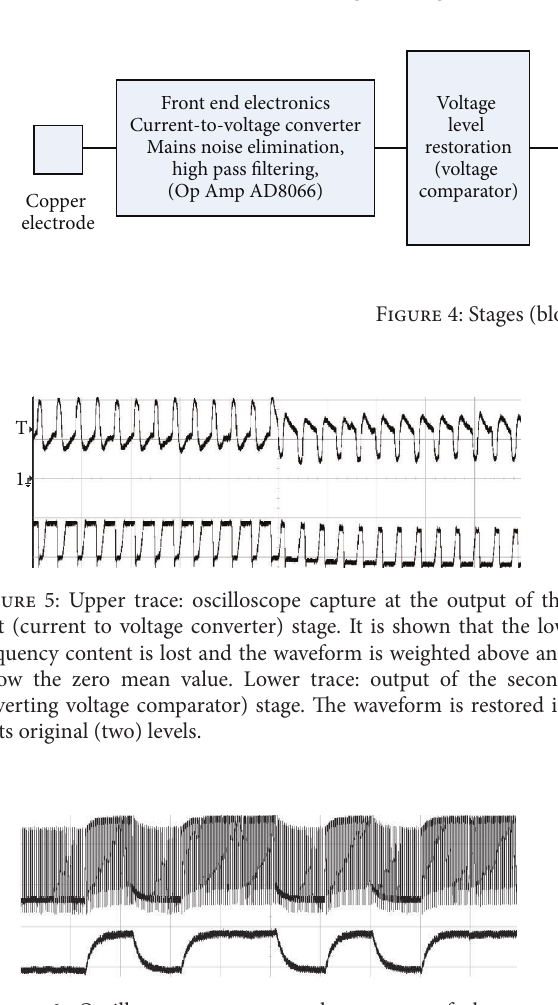
Figure 6: Oscilloscope capture at the outputs of the second (voltage comparator, different time scale) as the above and the third (demodulation Low Pass Filter) stages of the receiver. The two different duty cycles give two distinct voltage levels (despite being rounded) corresponding to the logic states.